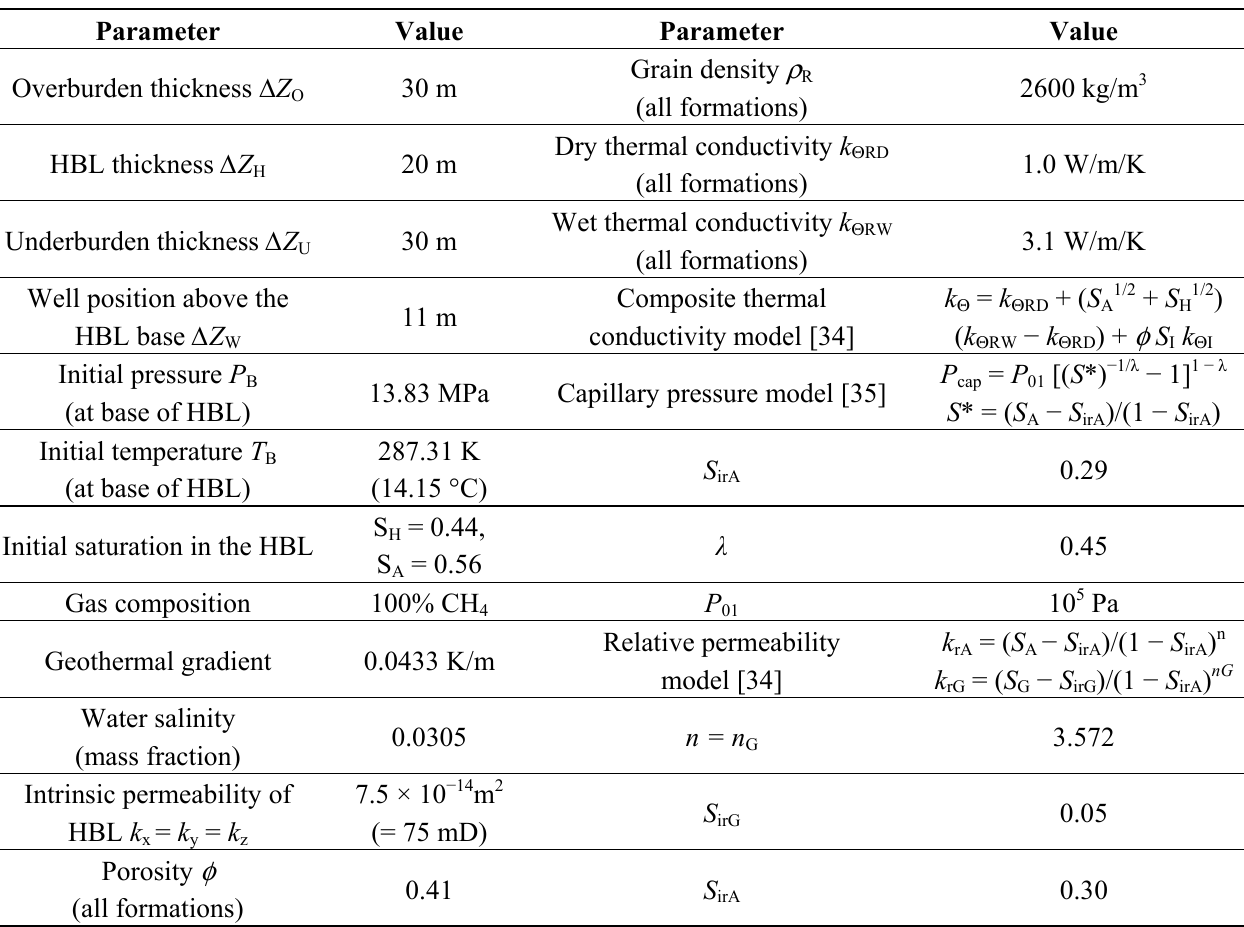
Table 1. Properties and conditions of the hydrate deposit at site SH7 in the Shenhu area, South China